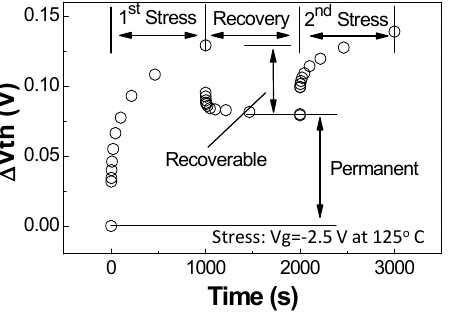
Figure 6. ( a ) The NBTI kinetics post-2000 does not follow a power law and has a “hump” when measured from the pulse (5 µ s) Id-Vg. Although the data after the “hump” appear to follow the power law, the fitted red line underestimated the power exponent. ( b ) The kinetics appear to follow the power law when measured at a slow speed (10 ms per point) [46].